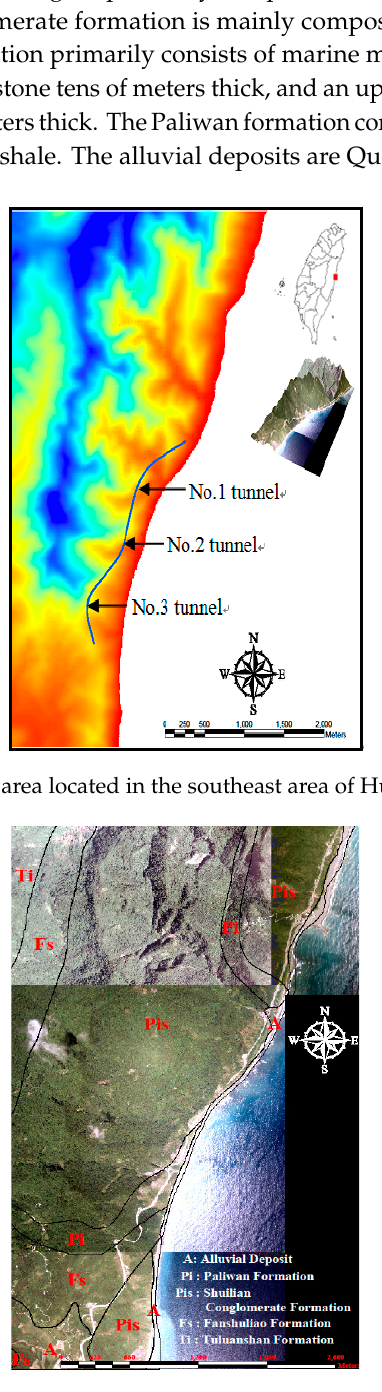
Figure 8. Geological distribution map of the study area. Table 2. Analysis results for stability of excavation slope at portal section.